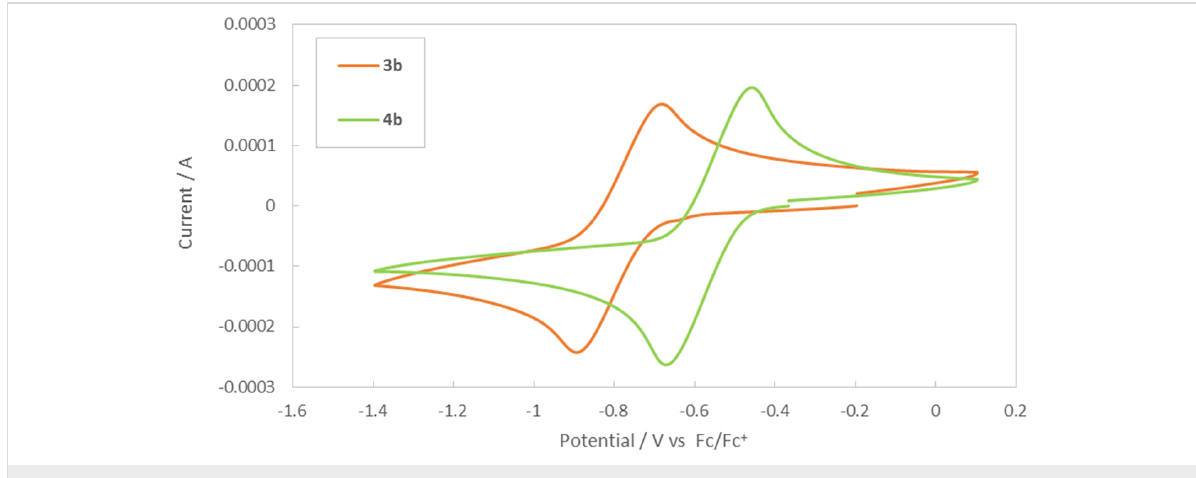
Figure 6: Cyclic voltammograms of thioxanthylium salts 3b and 4b .